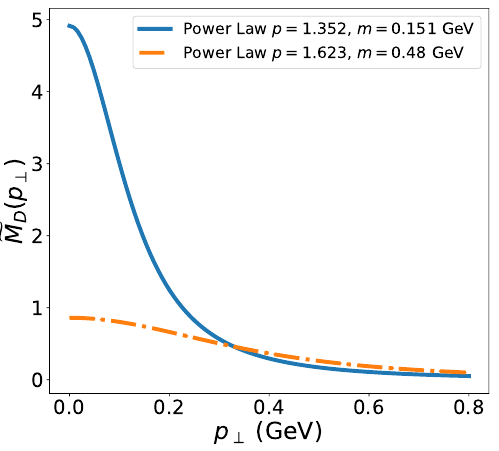
parametrizations in p -space: ⊥ D